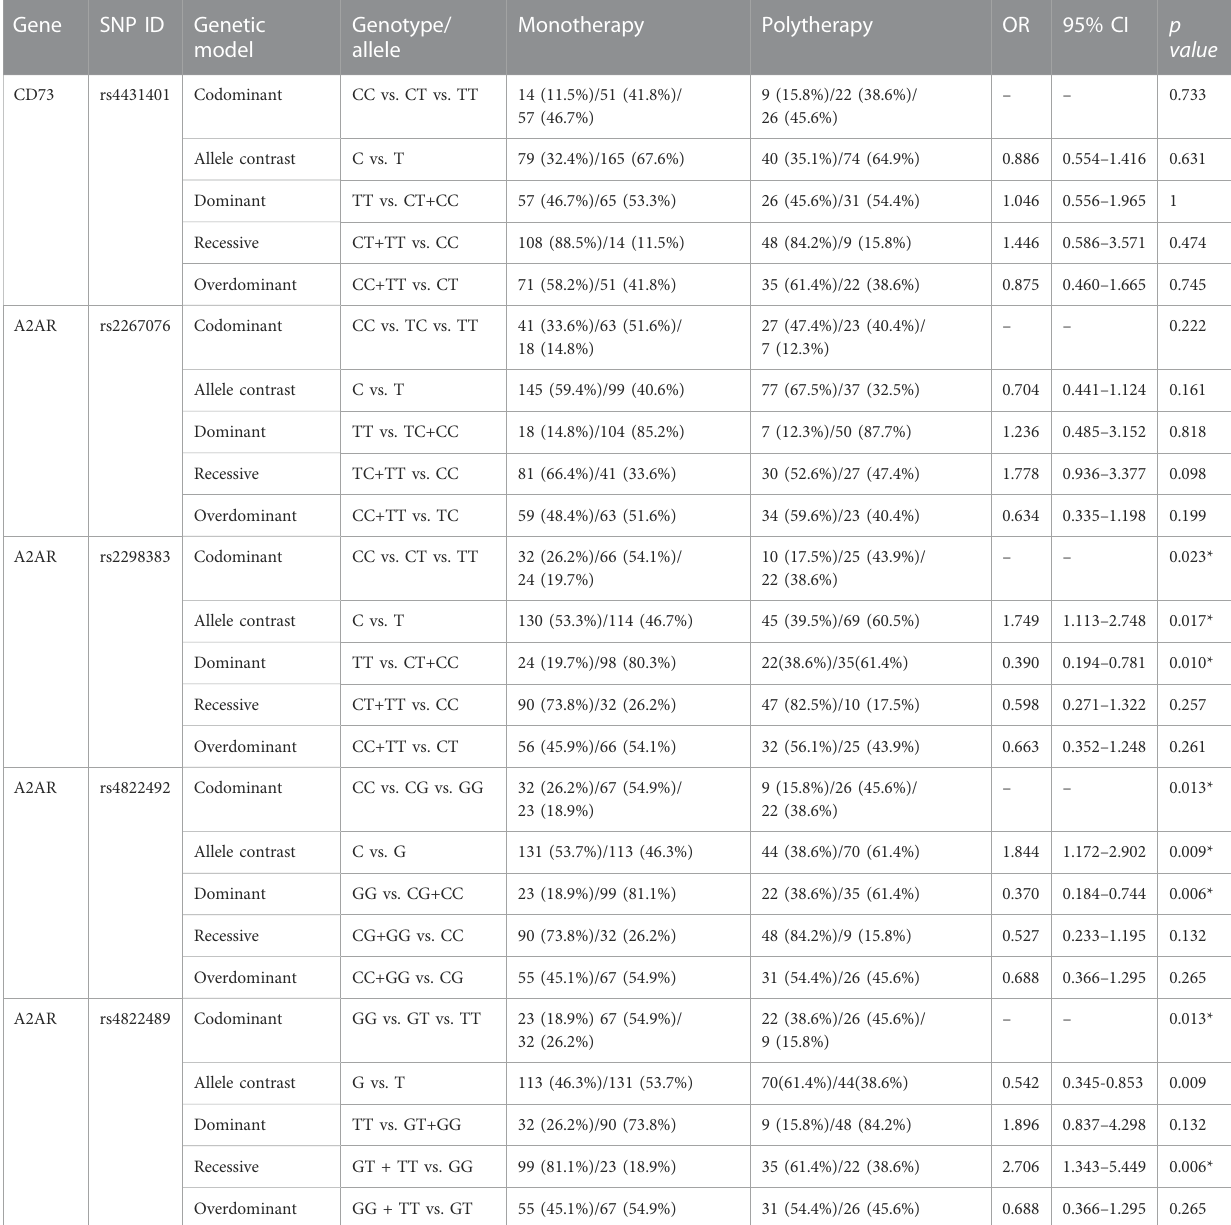
TABLE 5 Genotypic and allelic distribution of CD73 and A2AR genes between patients with monotherapy and polytherapy.